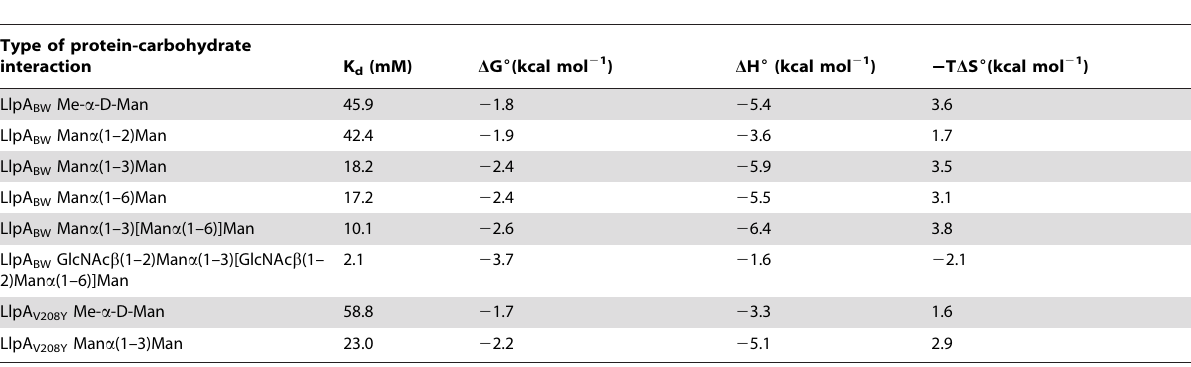
Table 1. Binding affinities and thermodynamic parameters obtained from ITC titrations.